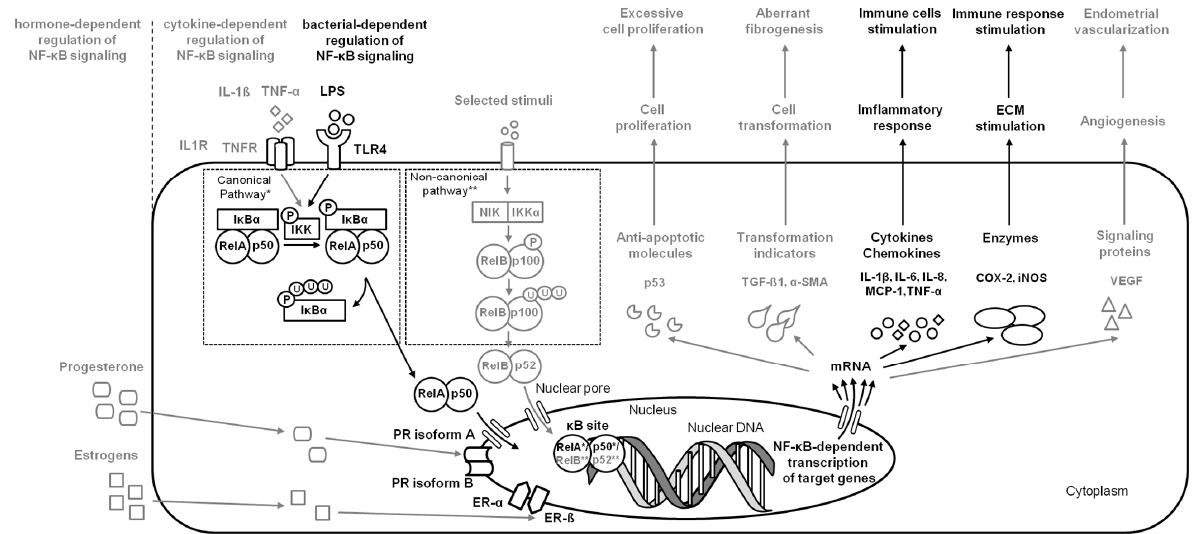
Figure 1. A simplified schema of the NF- κ B signaling pathway in the endometrium in the case of endometritis. Studied pathways are marked in black. Pathways requiring further research are marked in grey. Both canonical pathway * and noncanonical pathway ** are considered.